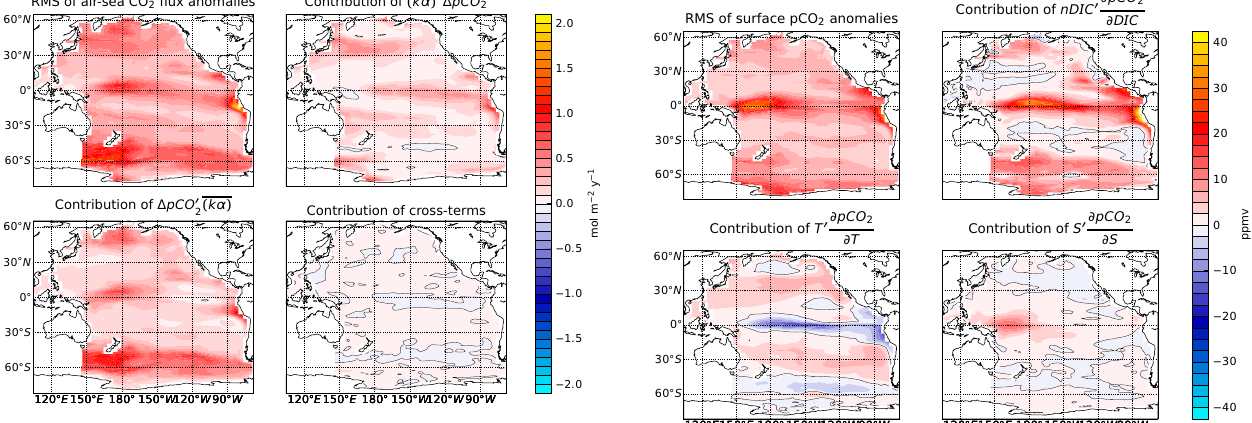
Fig. 3. Partitioning of the mechanisms driving interannual variabil- ity in air–sea CO 2 flux (molm − 2 yr − 1 ) in the Pacific Ocean in the CCSM ocean BEC model (Doney et al., 2009a). The panels show the root mean square (rms) of the model deseasonalized CO 2 flux anomalies (1990–2009) (top left) and the contributions from gas transfer velocity (wind speed and ice cover) (top right), surface- water 1p CO 2 (lower left), and the cross-correlation of gas transfer and p CO 2 sw anomalies (lower right).